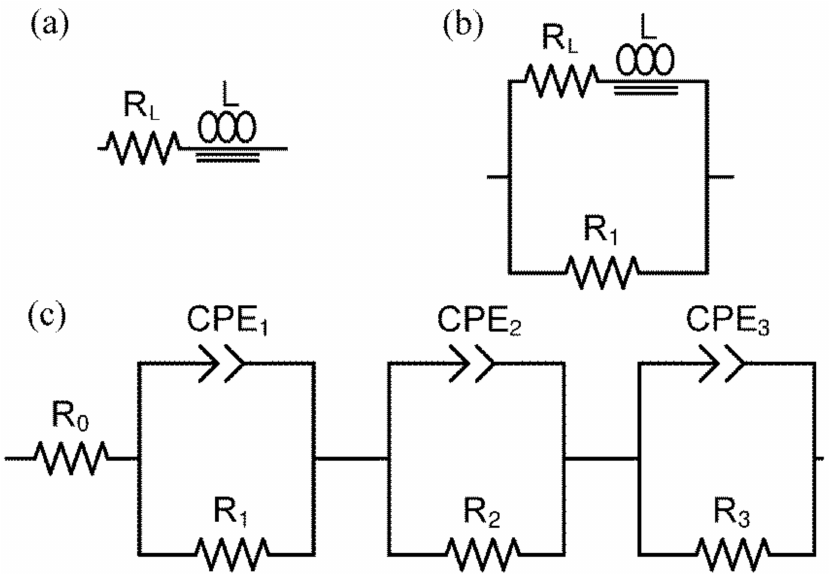
of the spectra with the real axis of the Nyquist (Z (cid:48) , Z (cid:48)(cid:48) ) plot was used to evaluate the resistance [46,47].